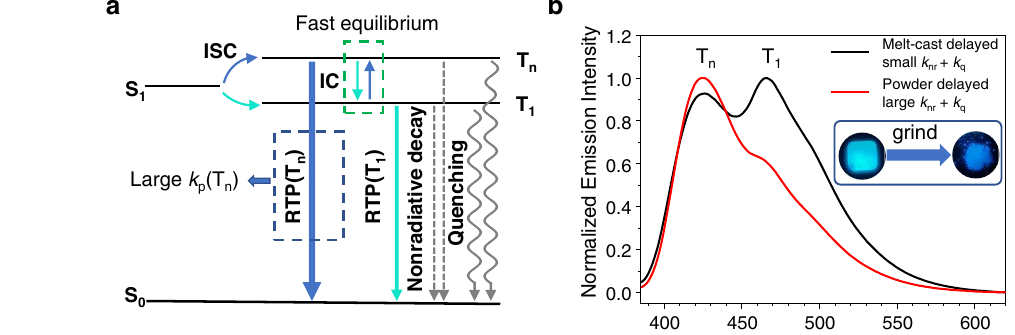
sample(blackline,withsmall k nr + k q value)andpowdersample(redline,withlarge k k nr + q value)and the phosphorescencephotographs after ceasing excitationlight source (UV off, 0.1s) under ambient